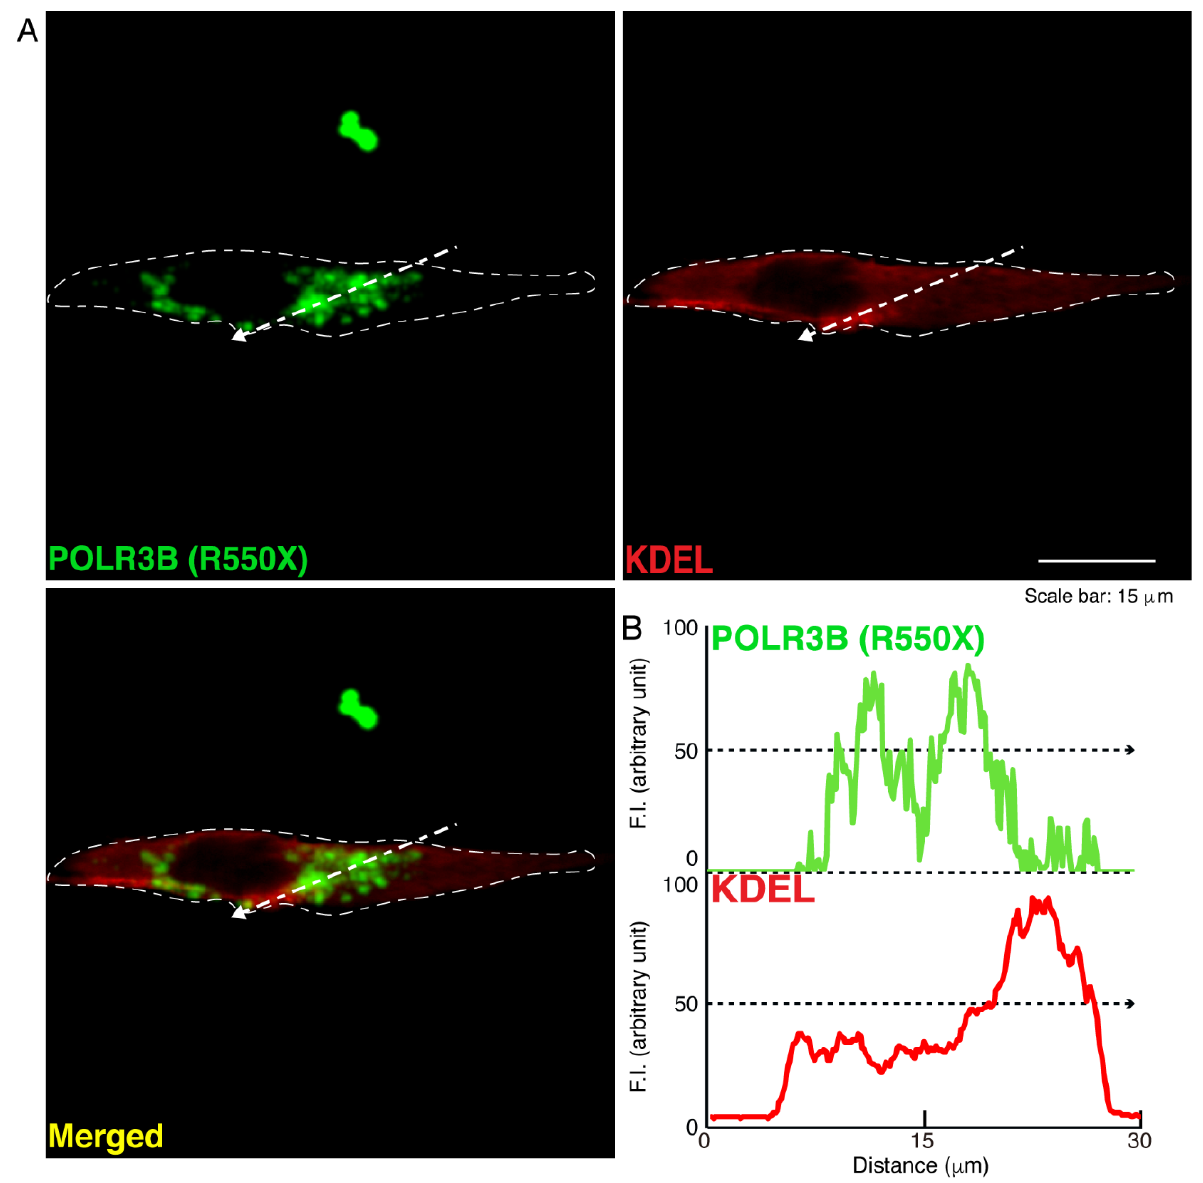
Figure 3. POLR3B mutated proteins are not co-localized with the ER in cells. ( A , B ) Cells were transfected with the plasmid encoding POLR3B (R550X) (green) and stained using an antibody against the KDEL antigen (red). Scan plots were performed along the white dotted lines in the direction of the arrows in the color images (green and red as well as merged images). Graphs showing the fluorescence intensities (arbitrary units) along the white dotted lines in the direction of the arrows (black dotted lines in right bottom panels) can be seen in the right bottom panels.